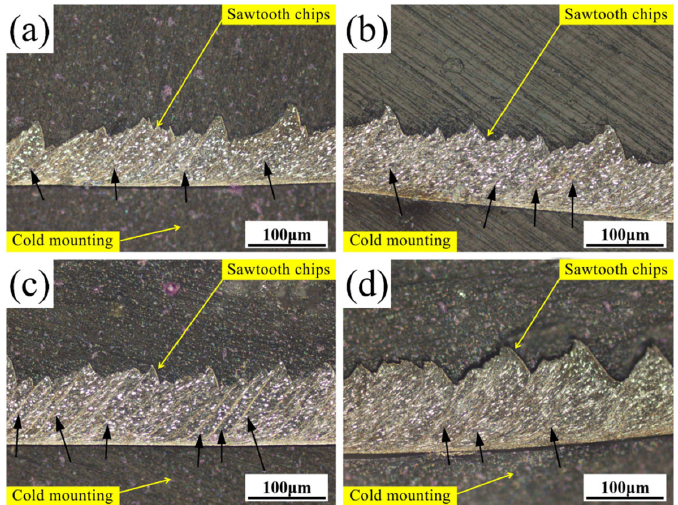
Figure 11. Cross-section microstructure of the chip using CCI: ( a ) CT; ( b ) 0.42 A/mm 2 ; ( c ) 0.57 A/mm 2 ; and ( d ) 0.90 A/mm 2 .